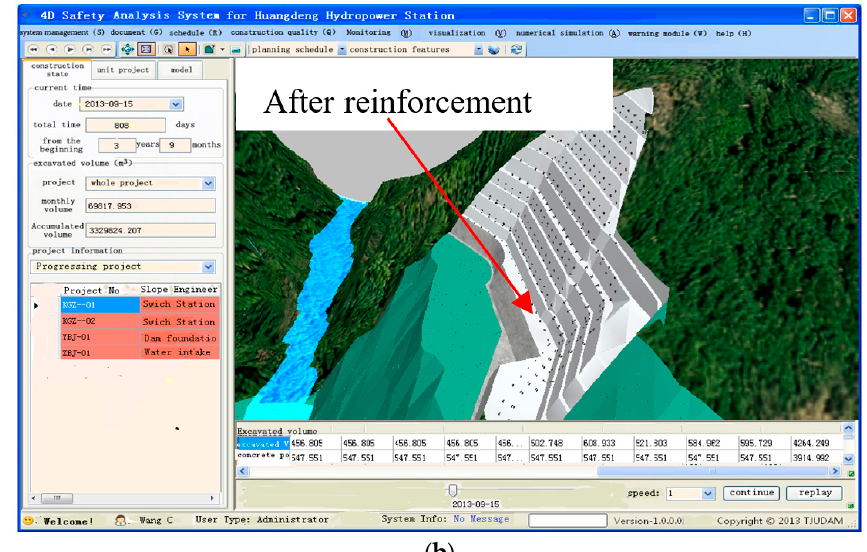
Figure 10. Visualization of the supporting schedules for the slopes. ( a ) Visualization of the supporting schedules before 10 September 2013; and, ( b ) Visualization of the supporting schedules after 10 September 2013.